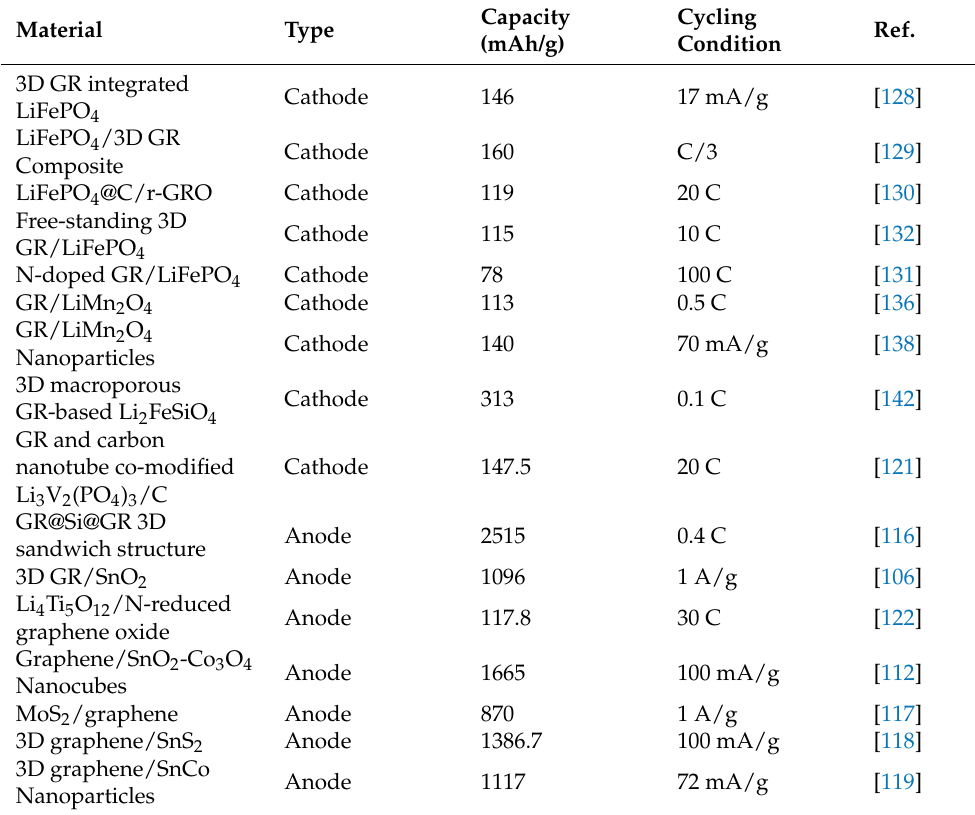
Table 3. Application of GR based electrode materials for LIBs.